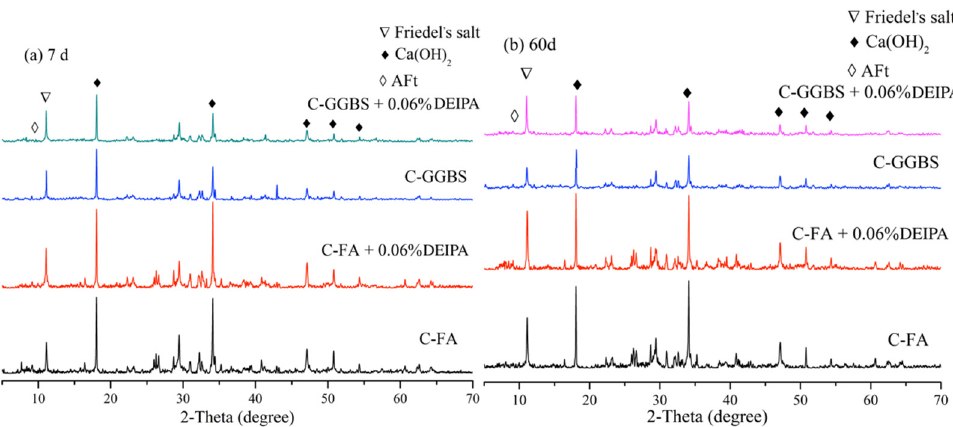
Figure 6. X-ray Diffractometry (XRD) patterns of samples hydrated for 7 d and 60 d, ( a ) 7 d, ( b ) 60 d.